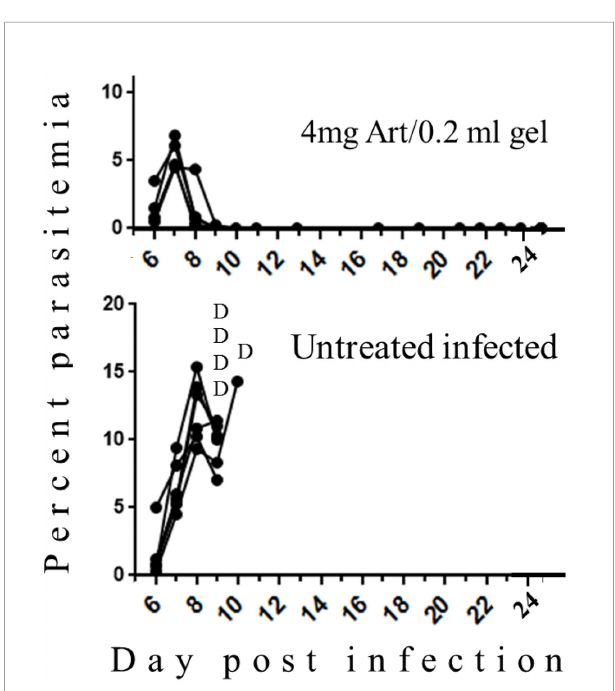
FIGURE 3 | The effect of late treatment at fi ve days post-infection with PbA. Each curve represents one mouse; Art, artemisone; D, death; Untreated n = 5; Treated n = 4, all